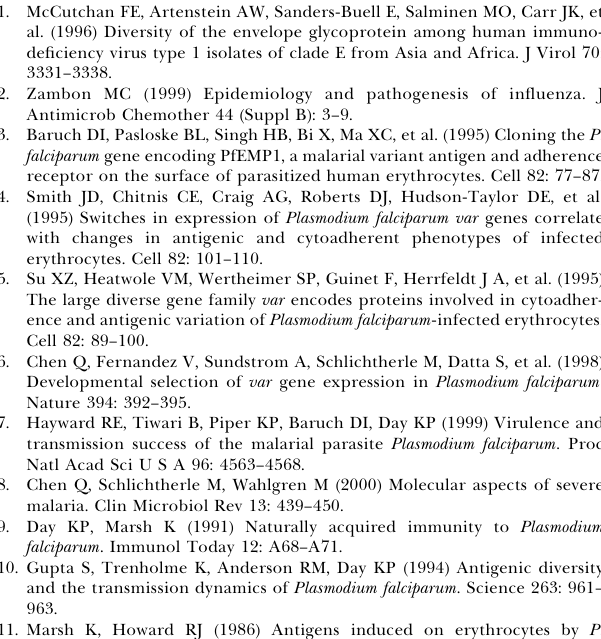
Figure S6. Multiple Alignment of Amele DBL a Types